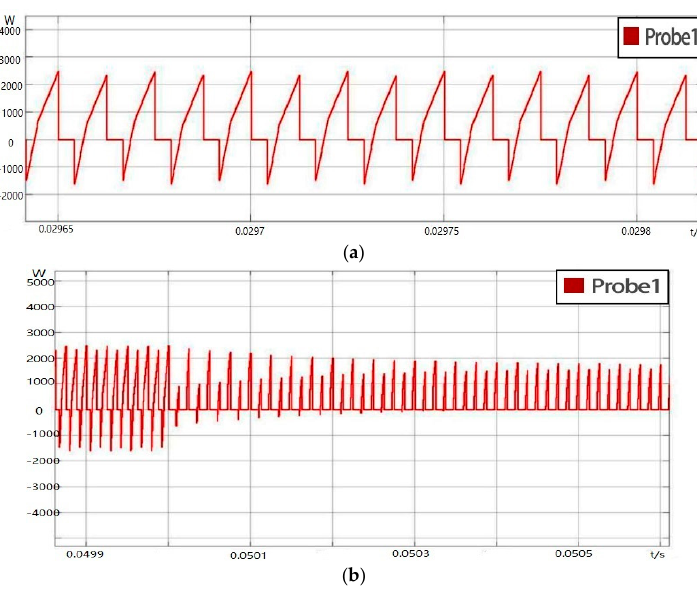
Figure 17. The power waveforms of the low voltage side of the transformer on ( a ) Steady state; ( b ) transient state.